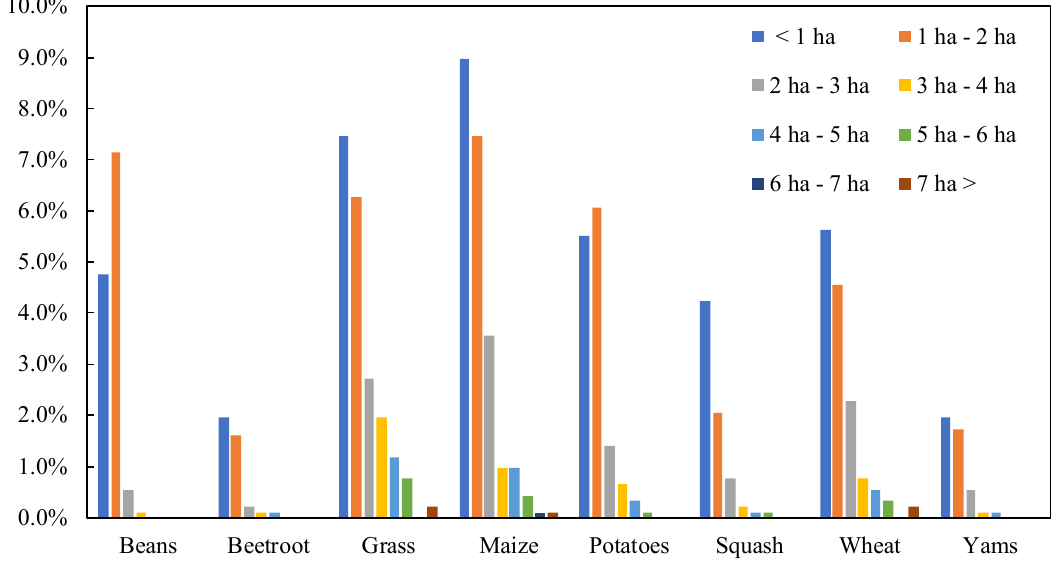
Figure 5. The relationship between field area and misclassified fields.